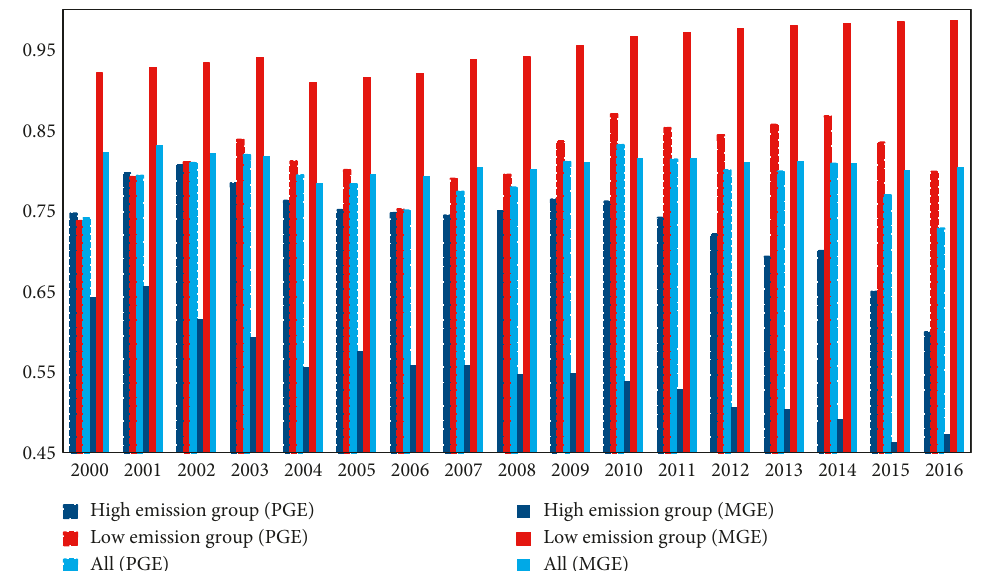
Figure 4: Comparison of metafrontier and pooled green efficiency in different groups.